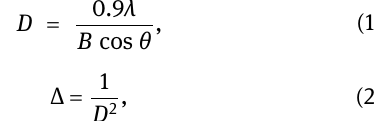
Table 1: Chemical composition of wrought AA2024 ( wt% )